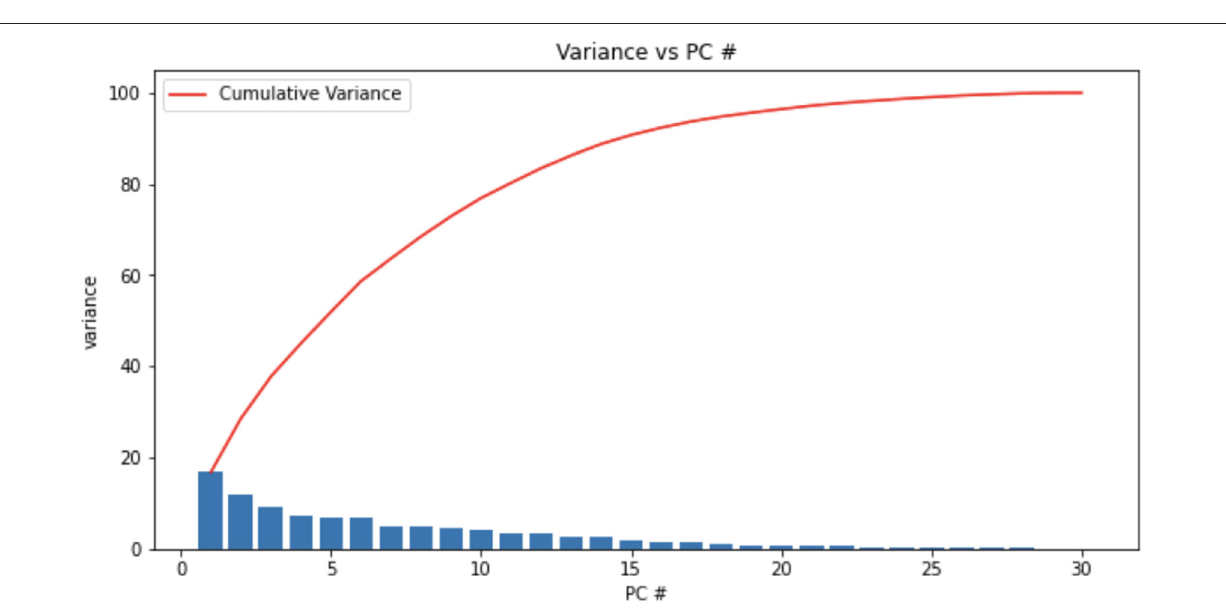
any impact on the results by Frank et al. (2013). The remaining columns were designated as the variable